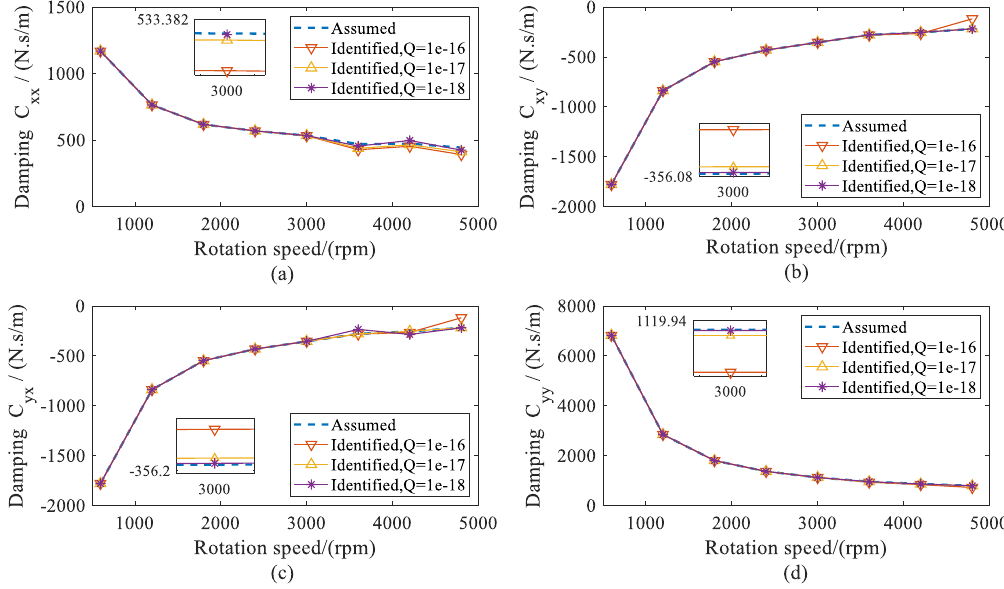
Figure 8. Assumed and identified damping coefficients of bearing 2 versus rotation speed. ( a ) direct damping coefficients C xx ; ( b ) cross-coupled damping coefficients C xy ; ( c ) cross-coupled damping coefficients C yx ; ( d ) direct damping coefficients C yy .